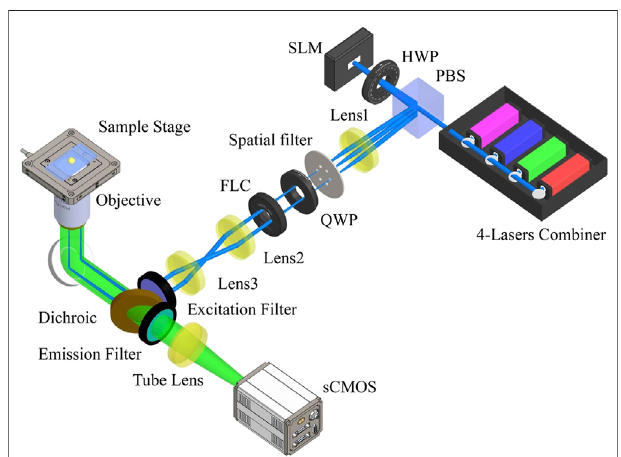
FIGURE 2 | Schematic of a high-speed SIM system. PBS, polarization beam splitter; HWP, half-wave plate; FC-SLM, ferroelectric liquid crystal spatial light modulator; QWP, quarter-wave plate; FLC, ferro-electric liquid crystalphaseretarders.ThelayoutissimilartotheoriginalSIMpresented in [15] but the hardware components have changed over the